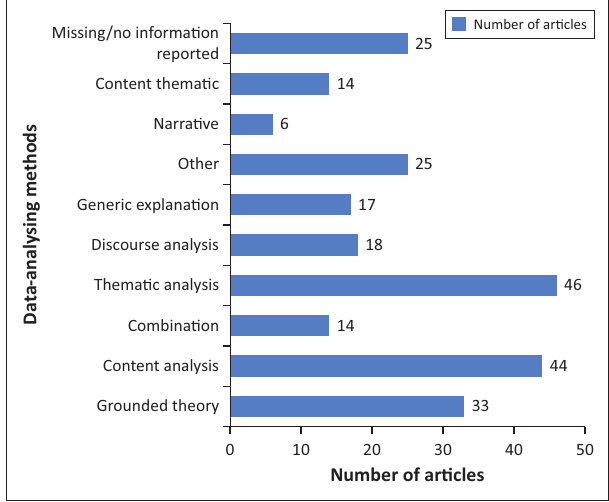
FIGURE 4: The various data-analysing methods featuring in the total sample of articles ( n = 242).